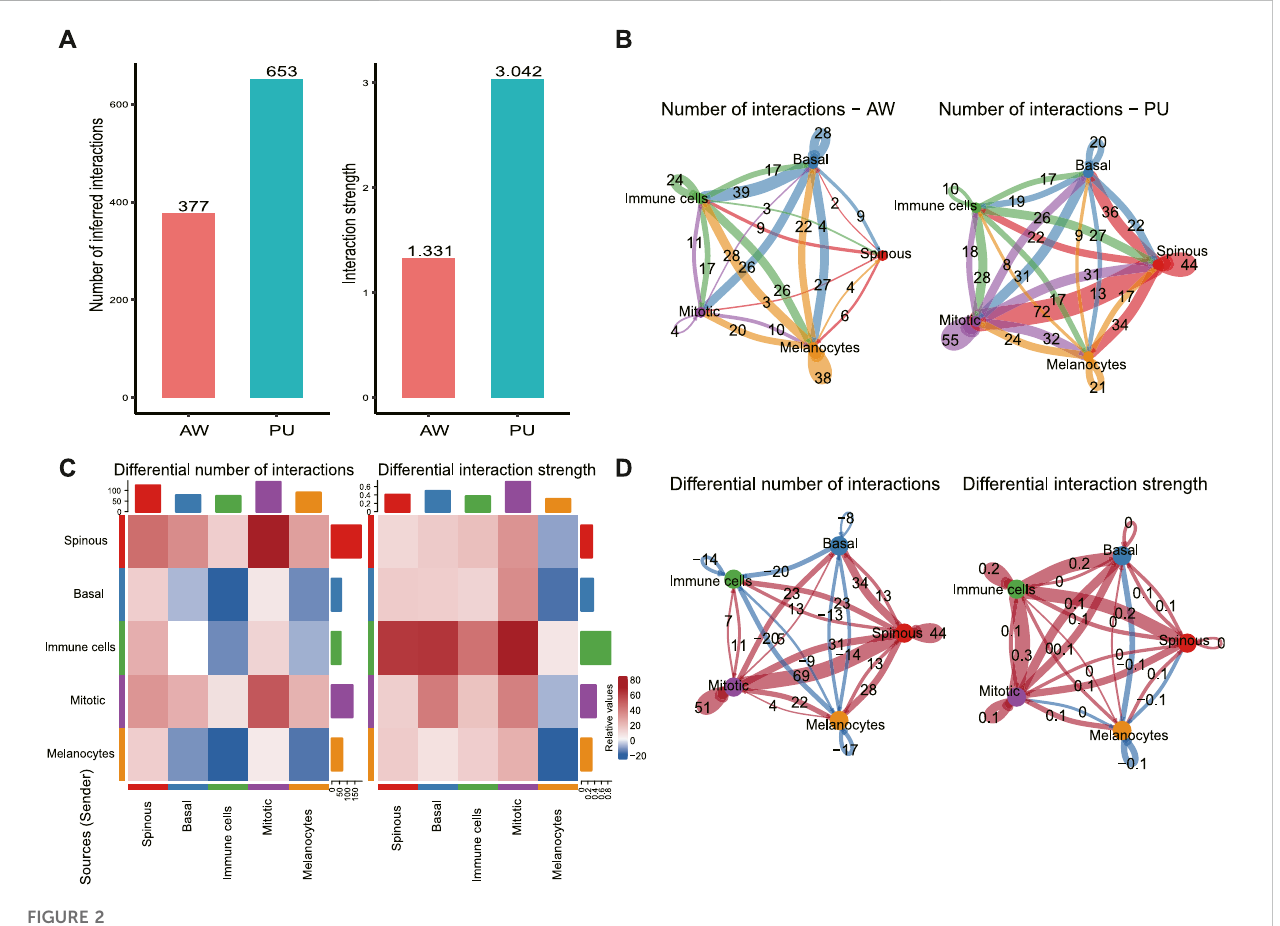
FIGURE 2 Cellular and molecular interactions of epidermal cells are enhanced in chronic wounds. (A) , Comparison of the total number of interactions and interaction strength; cell-cell communication is enhanced in chronic wounds. (B) , The number of interactions between any 2 cell populations in acute wounds (AW) and pressure ulcers (PU). (C) , The differential number of interactions and interaction strength in the cell-cell communication network between AW and PU. The top colored bar plot represents the sum of the column of values displayed in the heatmap (incoming signals). The right colored bar plot represents the sum of the row of values (outgoing signals). In the color bar, red (or blue) represents increased (or decreased) signaling in the PU compared to AW. (D) , The differential number of interactions and interaction strength between any 2 cell types. Red (or blue) colored edges represent increased (or decreased) signaling in the PU compared to the AW: acute wounds; PU: pressure